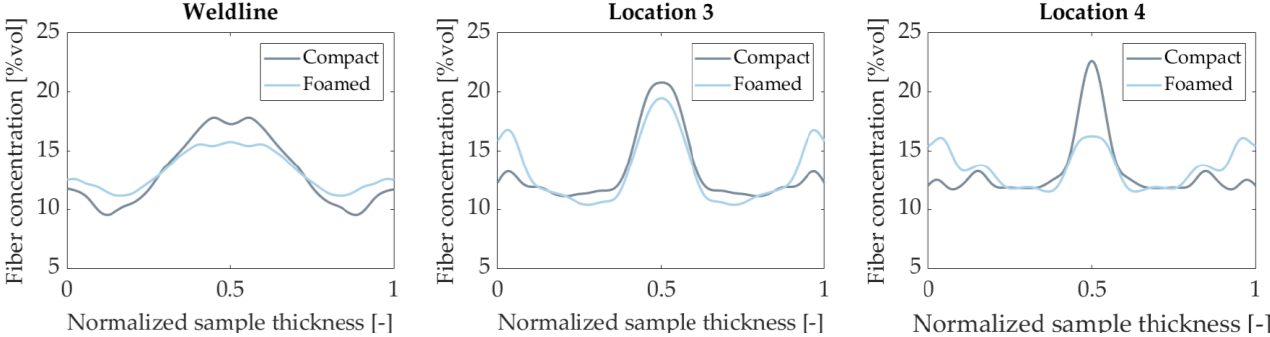
Figure 13. Symmetrical fiber volume fraction for compact and foamed panels at various sampling locations.